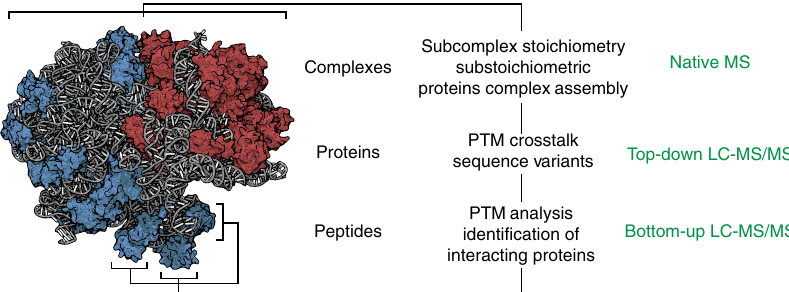
Fig. 1 Three-tiered mass spectrometry based approach for the dissection and characterization of ribosomal particles. The three-tiered hybrid mass spectrometry approach described here can provide insight into multiple molecular levels, ranging from the amino acid sequence of individual ribosomal proteins to the stoichiometric composition of the intact ribonucleoprotein particles. Which tier in the approach provides information on which level is indicated in green. The structural model of the E. coli 70S ribosome (PDB 4YBB) displays the rRNA in gray, the proteins of the 30S subunit in red and of the 50S subunit in blue